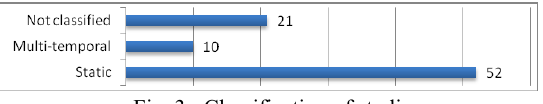
Fig. 3: Classification of studies Q.7: what is the suitable fusion level in this type of data